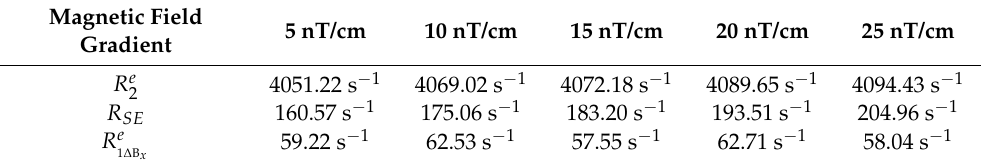
Table 3. Experimental results of magnetic gradient relaxation of alkali metal atoms in coupled spin ensemble under applied y -axis magnetic gradient.